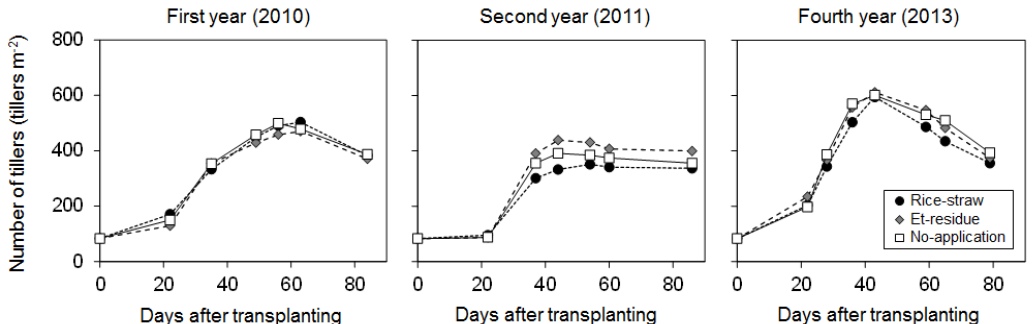
Figure 4. Time evolution of number of tillers in the first year (2010), second year (2011) and fourth year (2013). The number of tillers at 84 DAT in the first year, 86 DAT in the second year and 79 DAT in the fourth year corresponds to the numbers of panicles.